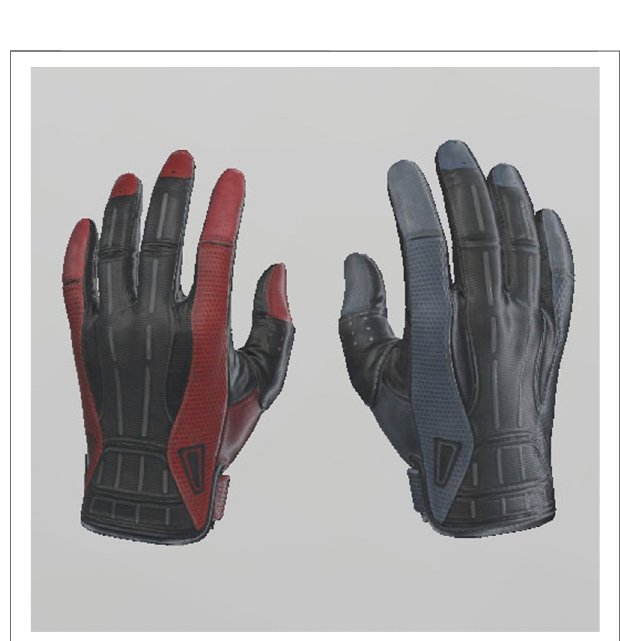
Frontiers in Virtual Reality |